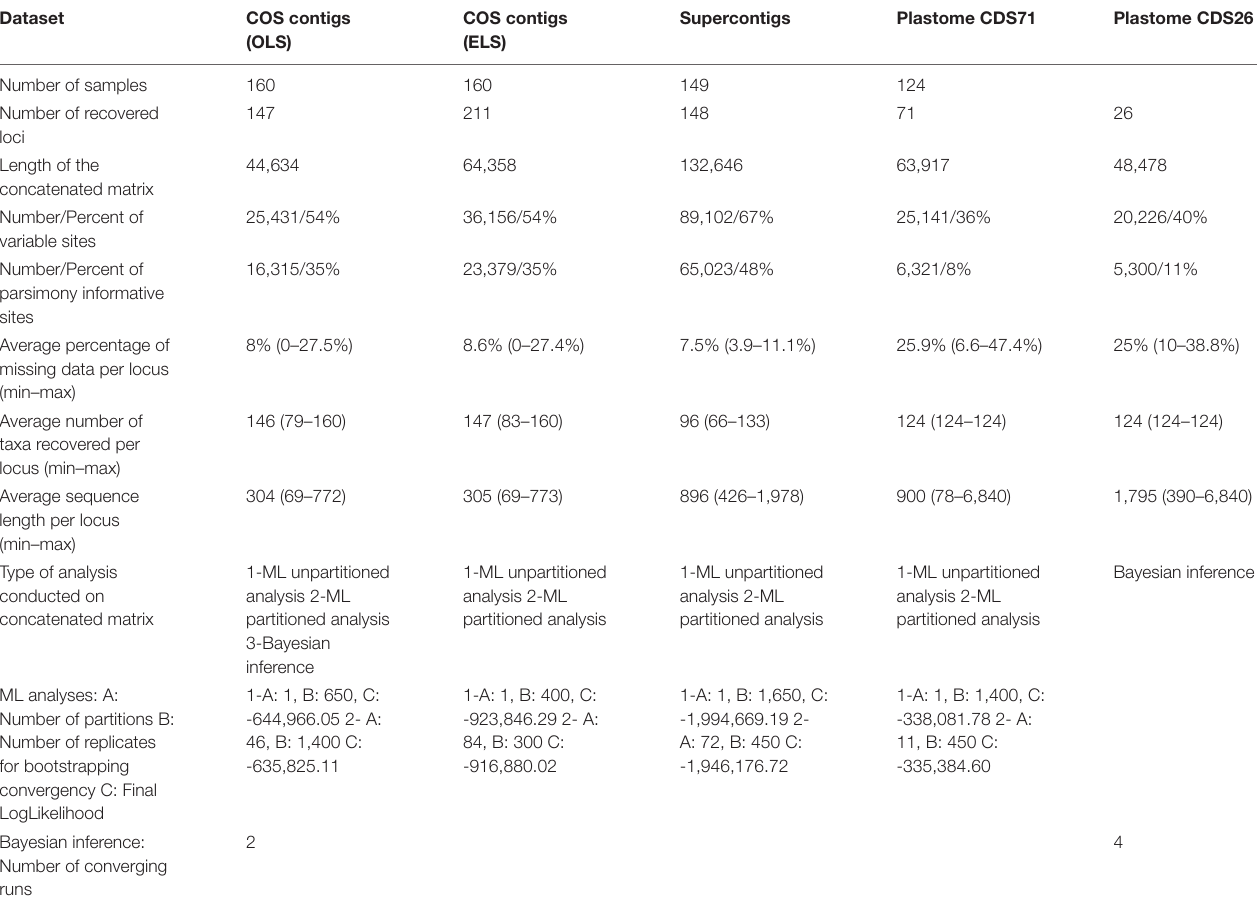
TABLE 1 | Statistics for the nuclear (OLS, ELS, and supercontig) datasets after removing loci with < 50% of all samples and plastome CDS dataset after cleaning process and a summary of analyses conducted on each dataset. Dataset COS contigs COS contigs Supercontigs Plastome (OLS) (ELS)